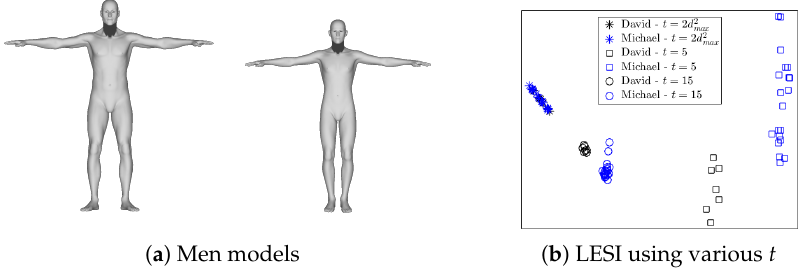
Figure 4. Experiment on separating different models of men: ( a ) a sample of Michael (left) and David (right) models; and ( b ) PCA projection of LESI descriptors of different men models using t = 2 d 2 max , t = 5, and t = 15.